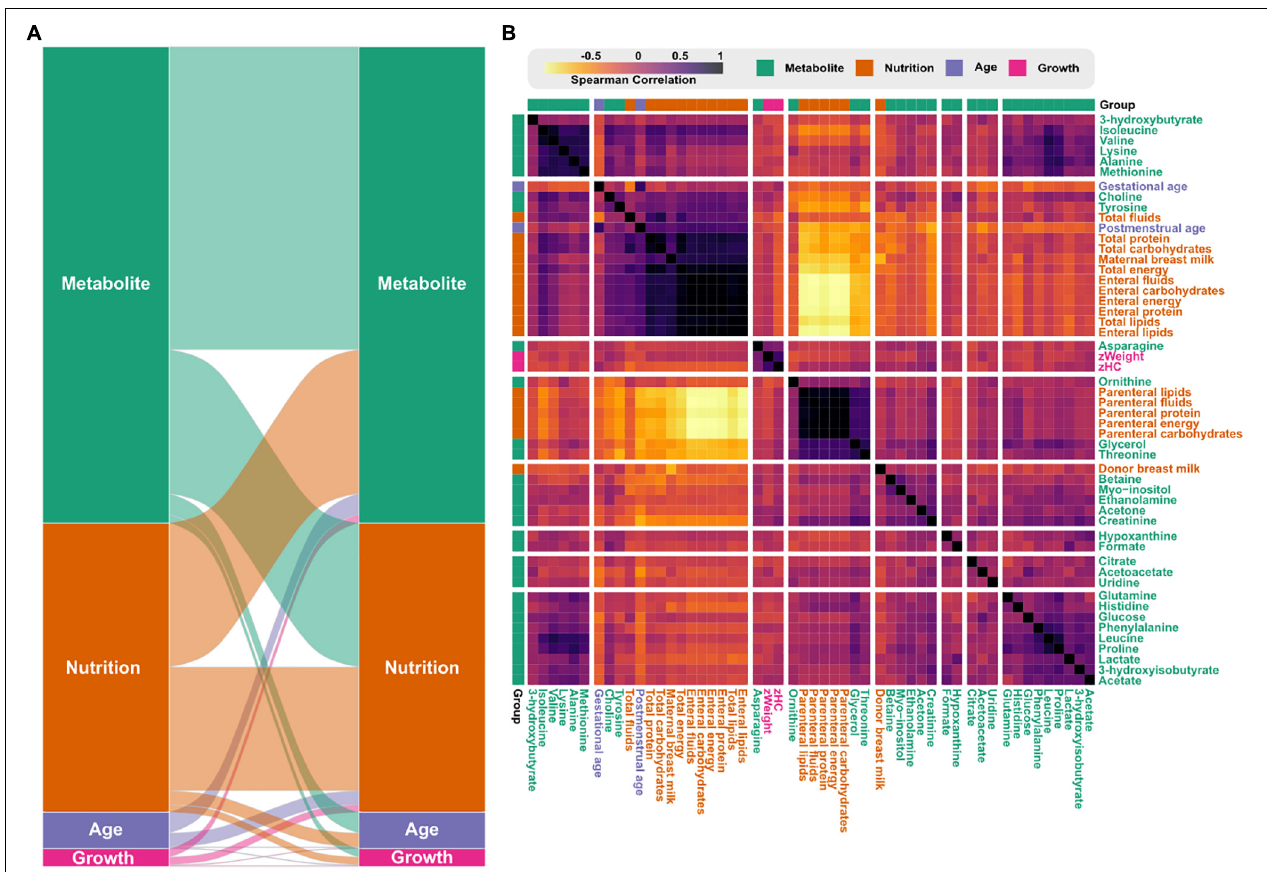
FIGURE 6 | Correlations between nutritional intake, growth, and the infant serum metabolome. (A) Flow diagram showing the correlations within and between variables groups based on Spearman correlations above 0.5. Link-width is proportional to the number of features correlating between the variable groups. (B) Heatmap with hierarchical clustering based on the pairwise Spearman correlations between variables. Color reflects the Spearman’s rank correlation coefficient accordingly to the